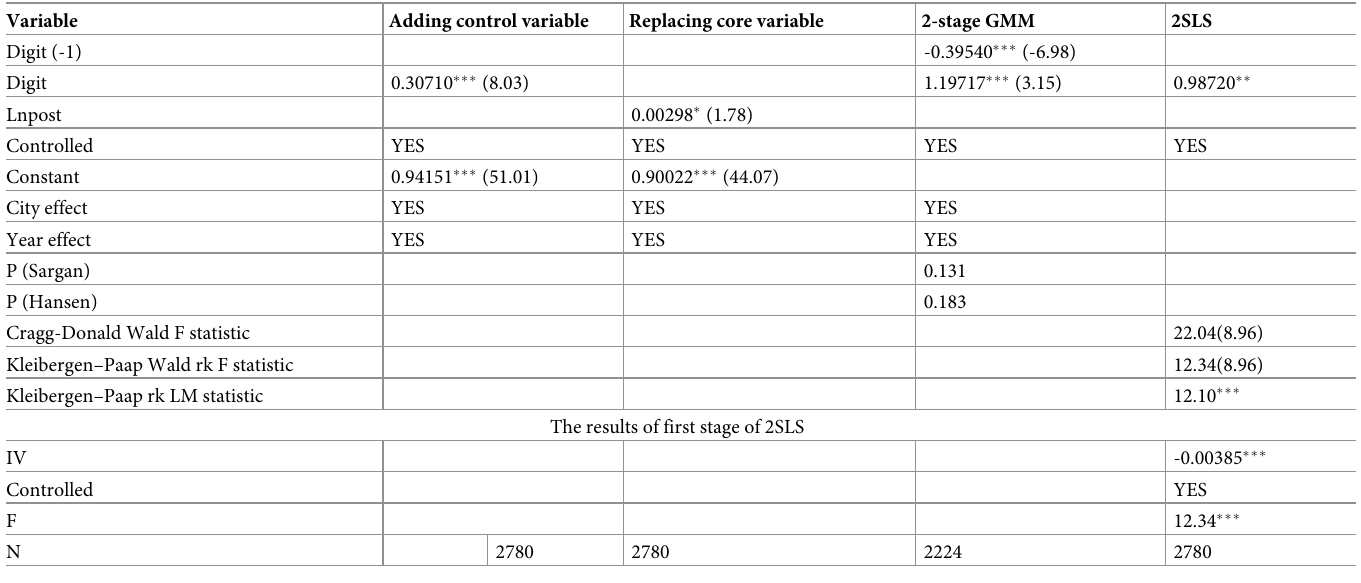
Table 5. Results of the robustness test of the benchmark